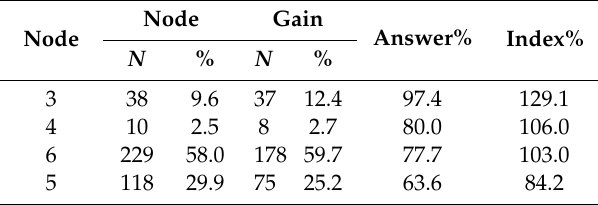
Table 9. Earnings for nodes: target those who do use Instagram.